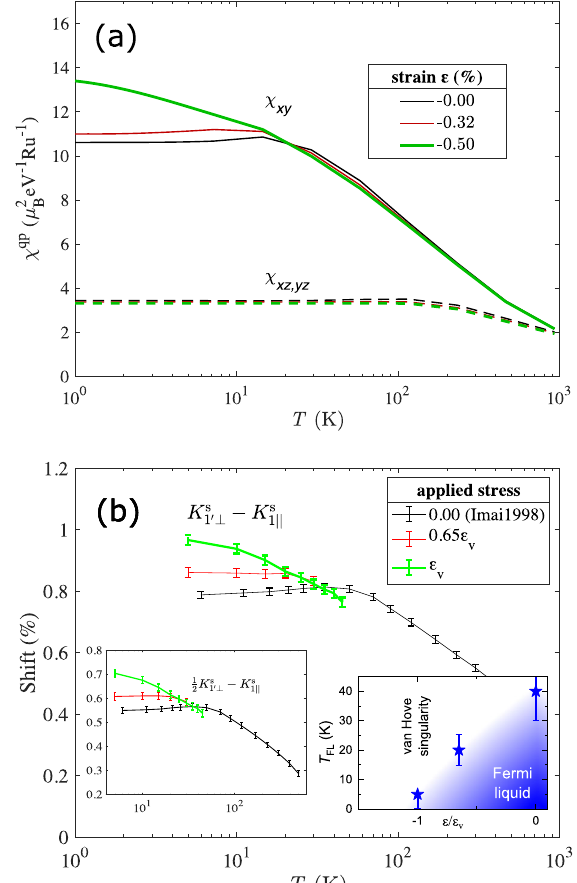
Fig. 3 Comparison between calculated and measured suscept- ibility. a Susceptibility evaluated from the quasiparticle Hamiltonian as a function of temperature and a -axis strain, χ qp ( ε aa , T ). The susceptibility is resolved into contributions from the three t 2 g orbitals. The critical (compressive) strain is close to ε aa = − 0.50%. (cid:3) K s b Experimentally determined K s as a function of tempera- 1 0 ? 1 jj ture and applied stress, referenced to the critical stress ε v . K s denotes the spin part of the total shift. To calculate the difference continuously, shifts have been interpolated from Fig. 1 after ¼ þ 0 : 18 % , subtraction of the known orbital contribution. ( K o 1 jj ¼ 0 : 0 % ) 40 . Error bars are determined by the average linewidth K o 1 0? of the two sites. The inset on the right illustrates the Fermi-liquid crossover temperature as a function of uniaxial strain, extracted from our Knight-shift data. The de fi ning criterion is the shift extremum separating the regimes of T -independent behavior, and that of logarithmic T -dependence. Error bars denote the tempera- ture range in which the shift variation about the extremum is less than the